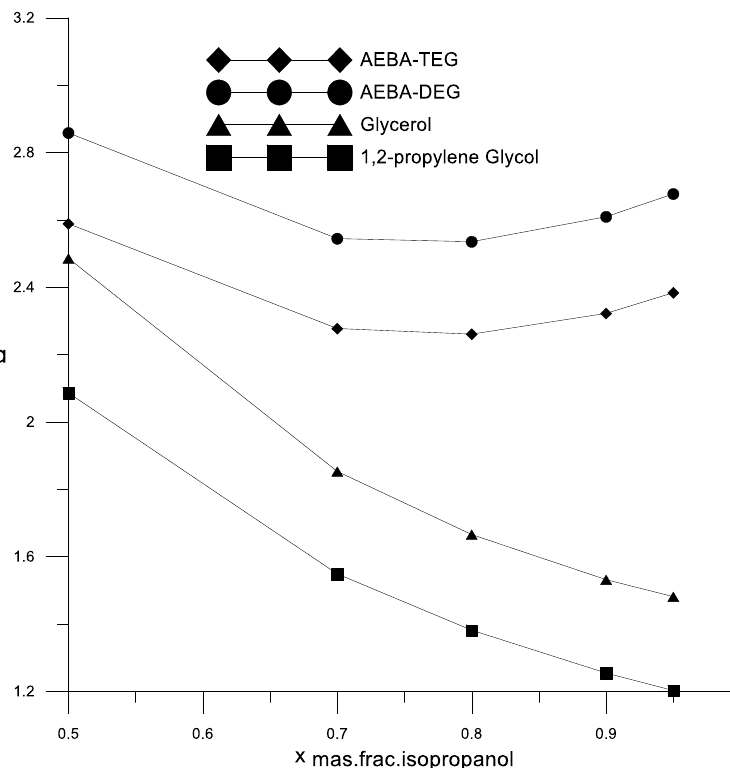
Figure 7. The coefficient of the components relative volatility of the isopropanol – water mixture in the Figure 7. The coe ffi cient of the components relative volatility of the isopropanol–water mixture in the presence of various presence of various extractants.